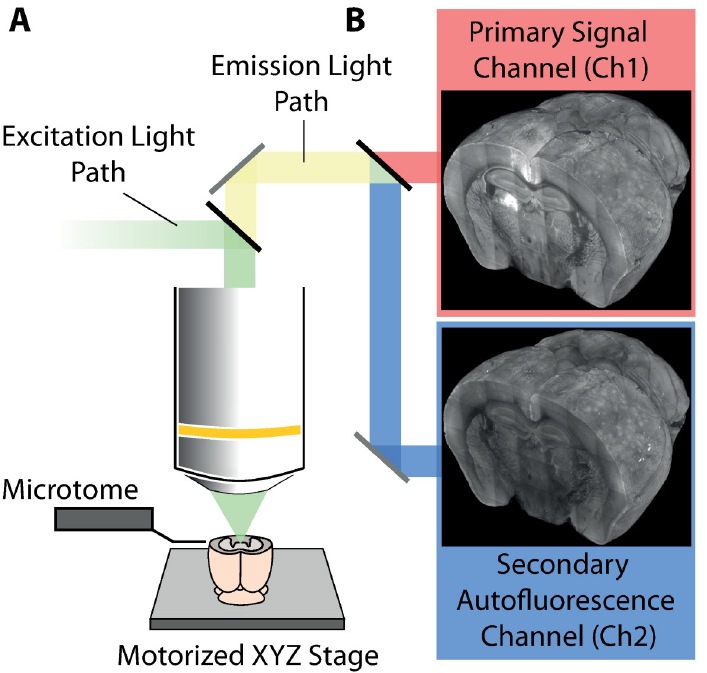
Fig 1. Simplified schematic diagram of the serial two-photon microscope and data acquisition process. A: The tissue is excited using a femtosecond Ti-sapphire laser (emission wavelength = 800 nm). For data collection, 50 μ m of tissue (at approximately 40 μ m to 90 μ m below the tissue surface) is imaged in ten, 5 μ m thick planes. An in-built microtome then physically removes a 50 μ m thick section from the optical face. This process is repeated to generate a complete 3D dataset of the specimen. B: For signal collection, the emitted lightpath is split into two channels whereby the primary channel detects the fluorescence signal of interest from labelled cells (e.g. mCherry at 610 nm) and the second channel (e.g. at 450 nm) detects the tissue autofluorescence signal that reveals gross anatomical structure.